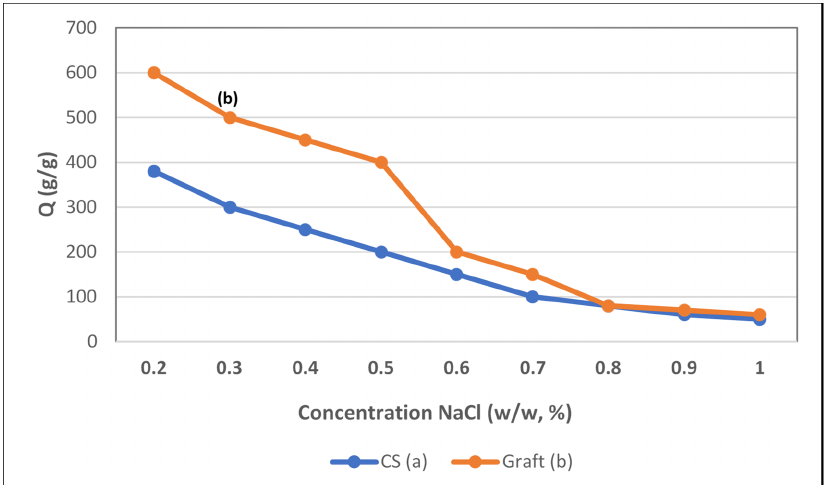
Figure 6. Water absorption capacity in different concentration salt solutions of superabsorbent (b) (%G = 60.65), as compared to CS (a).